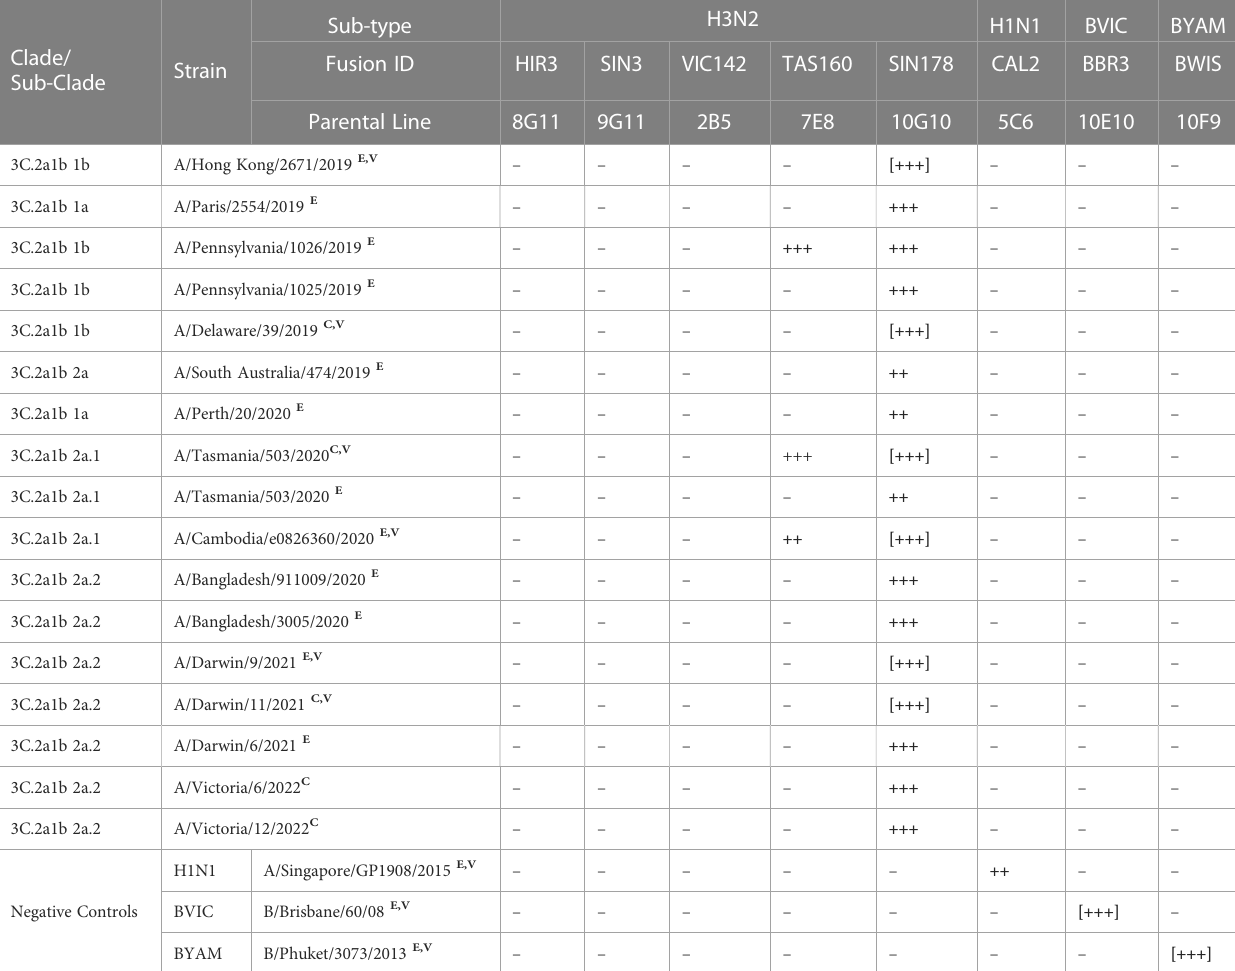
TABLE 2 Cross reactivity of monoclonal antibody (mAb) panel speci fi c to sub-type H1N1 screened against egg derived (E) and cell derived (C) vaccine antigen.